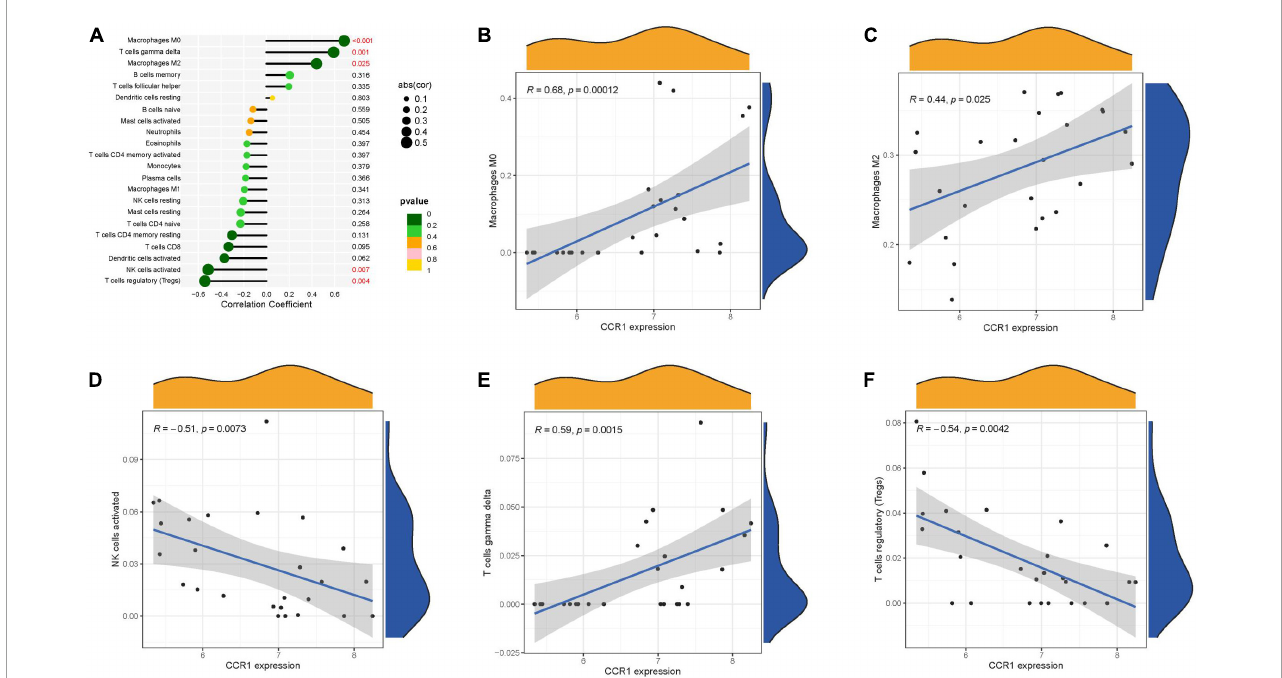
FIGURE8 Immune correlation analysis of CCR1. (A) Immune correlation lollipop chart. (B–F) Immune cells and CCR1 correlation scatter